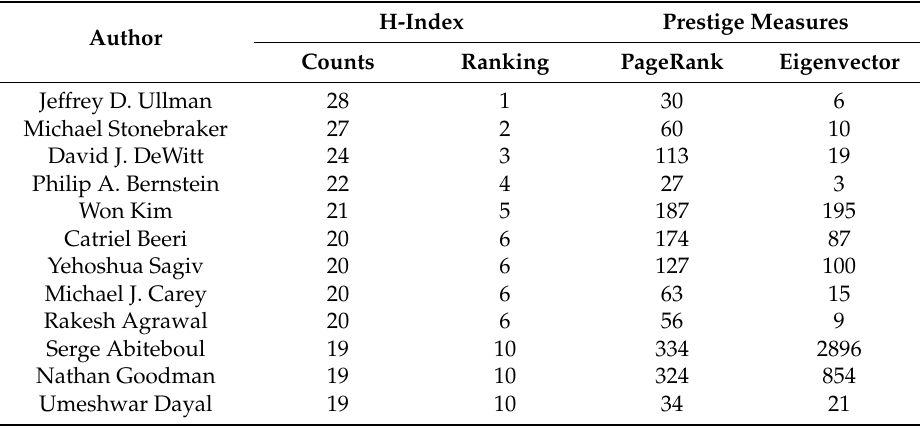
Table 6. Top 40 authors based on the